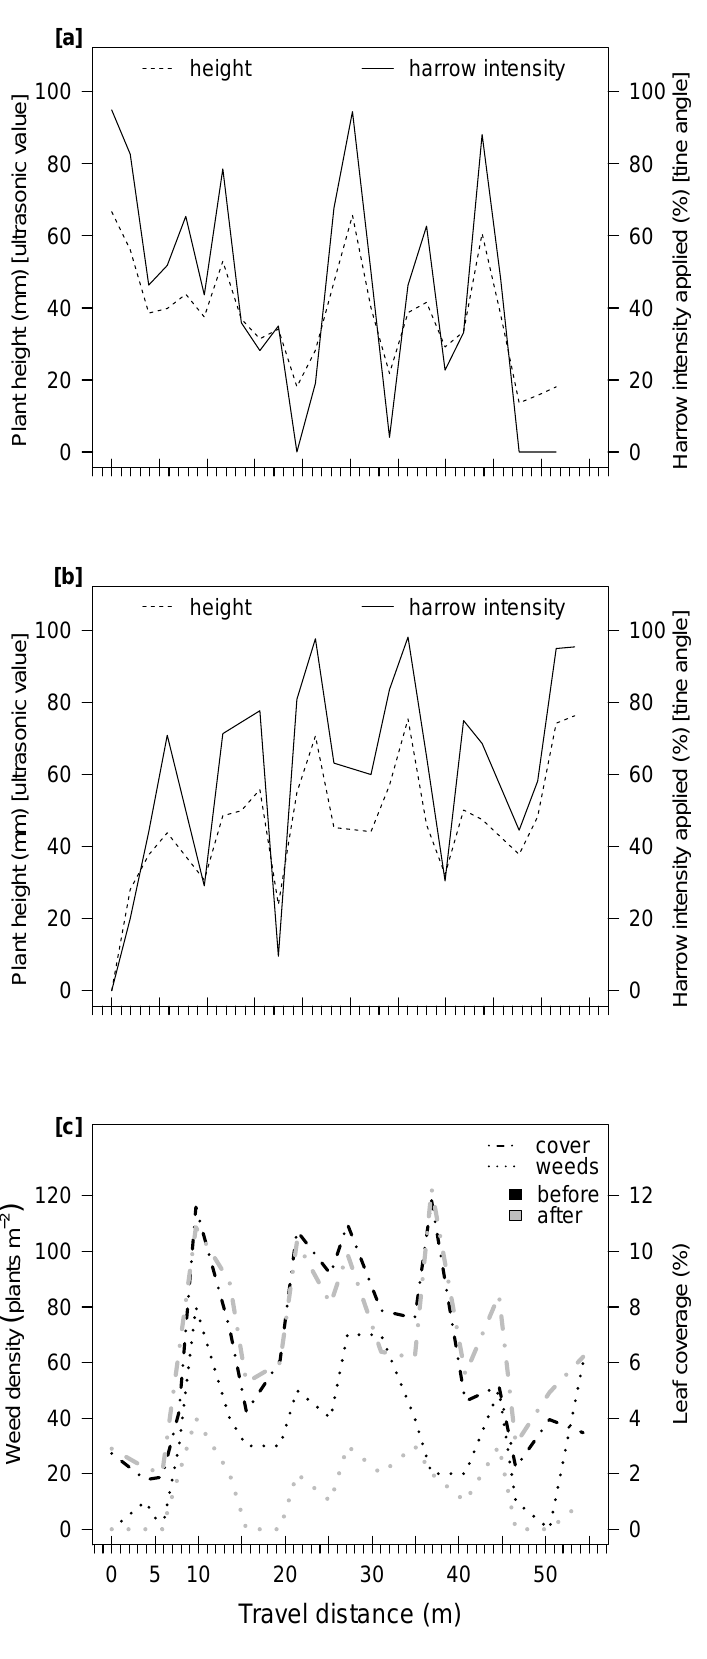
Figure 4. Ultrasonic value of plant height and harrowing intensity applied by the control unit in experimental plot A, first pass ( a ) and second pass ( b ); and variation in weed density and leaf cover before and after harrowing ( c